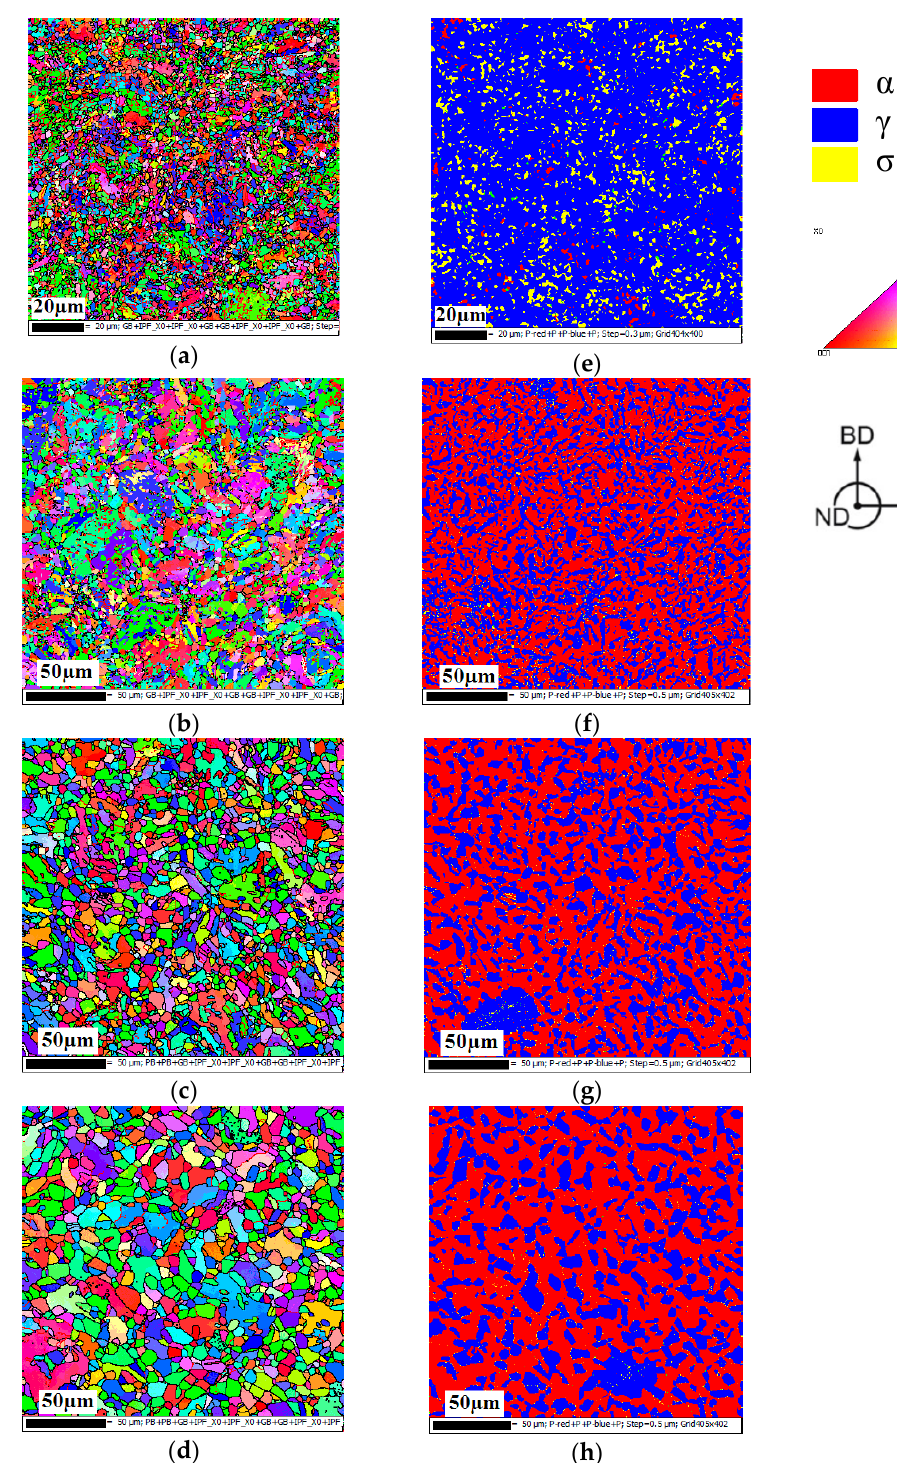
Figure 3. The electron backscatter diffraction (EBSD) diagram of different solution annealing processes ( a – d ) inverse pole figure and ( e – h ) phase distribution figure; ( a , e ) S2; ( b , f ) S3; ( c , g ) S4; ( d , h ) S5.